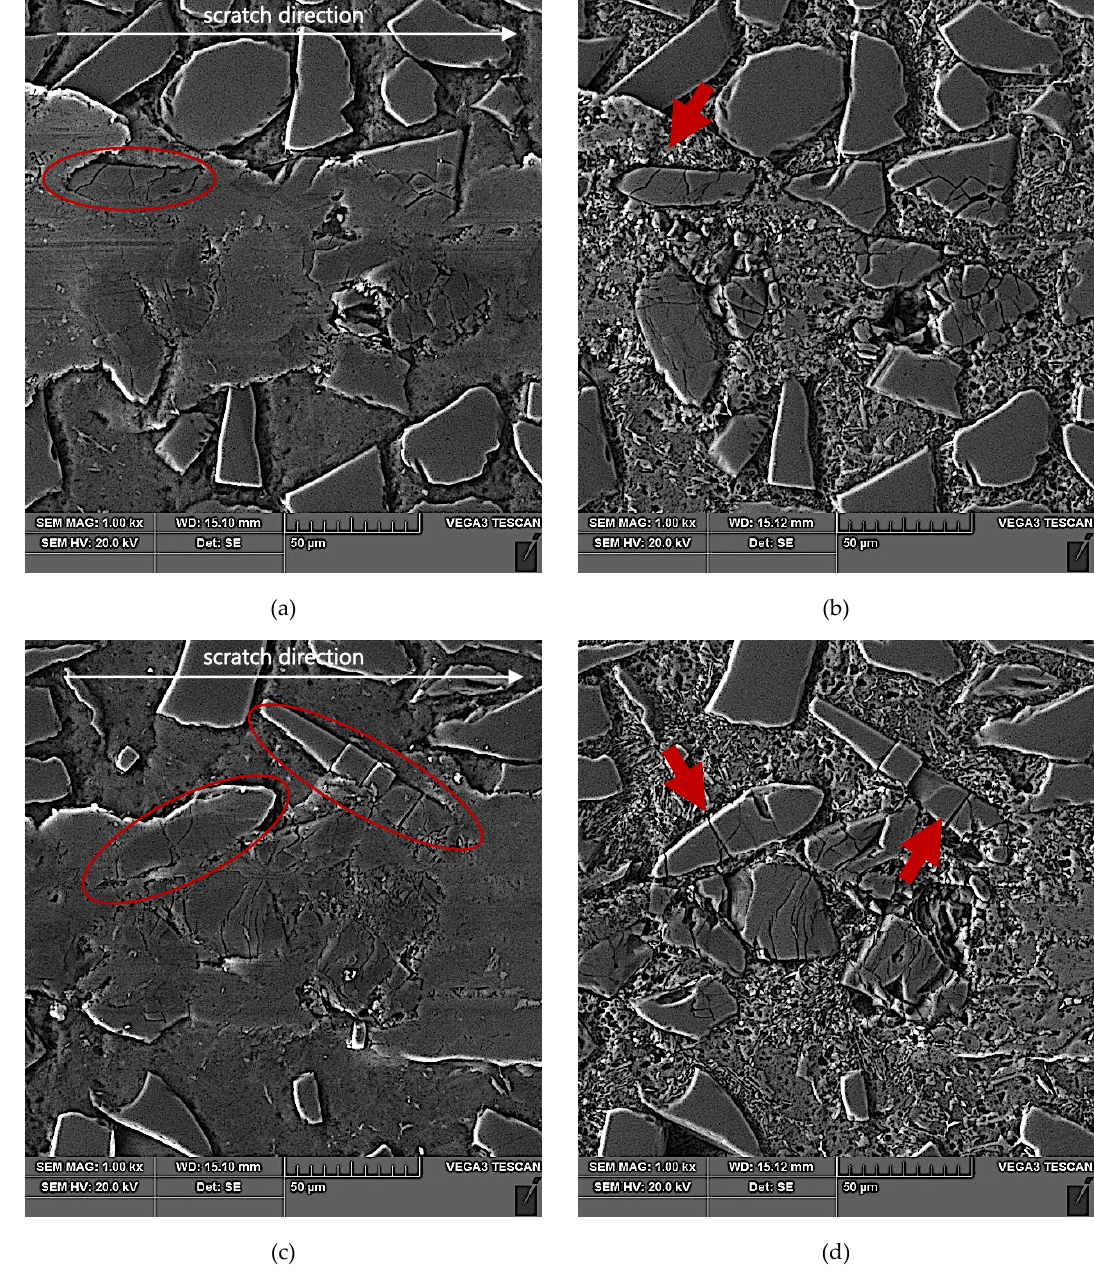
Figure 12. SEM images of a scratch made by the diamond indenter loaded with force of 5 N in the AlSi12/SiC p composite layer area: ( a ) and ( c ) matrix smearing and particles cracking are visible; section etched with 20% NaOH solution for 2 s; ( b ) degradation of the SiC particle oriented longitudinal to the scratch direction has been marked with a red arrow; section etched with 20% NaOH solution for 60 s (deep etching); ( d ) degradation of the elongated SiC particles oriented quasi-parallel to the scratch direction have been marked with a red arrows; section etched with 20% NaOH solution for 60 s (deep etching).